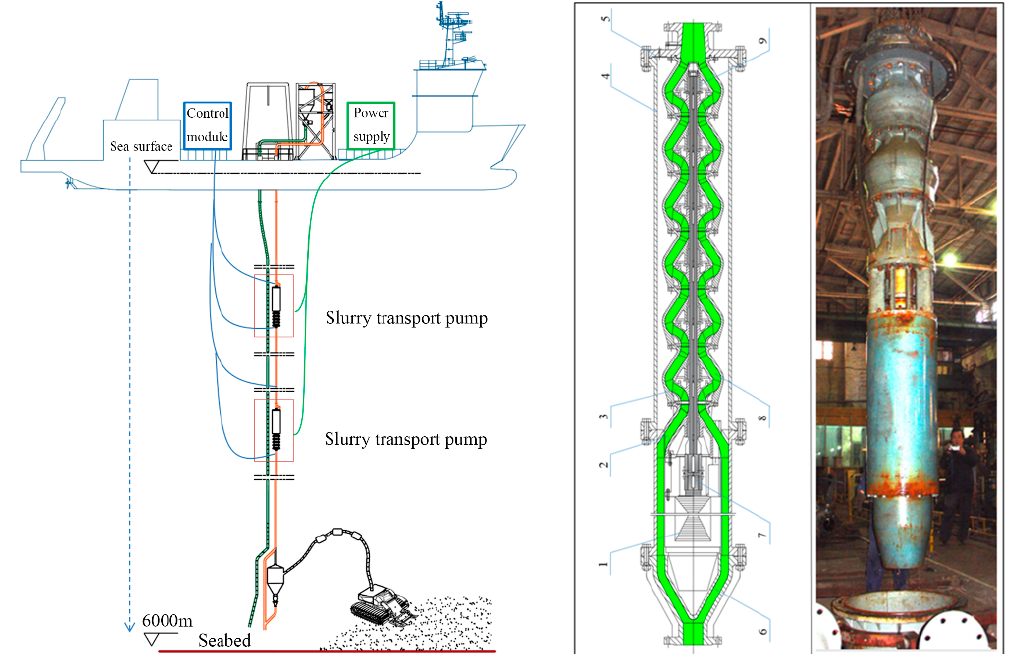
Figure 1. Schematic diagram of a deep-ocean mining system. Slurry transport pump: (1) submersible motor, (2) coupling pipe, (3) pump rotor, (4) out shell, (5) discharge, (6) suction, (7) shaft coupling, (8) diffuser, (9) and sliding bearing (no sealing).